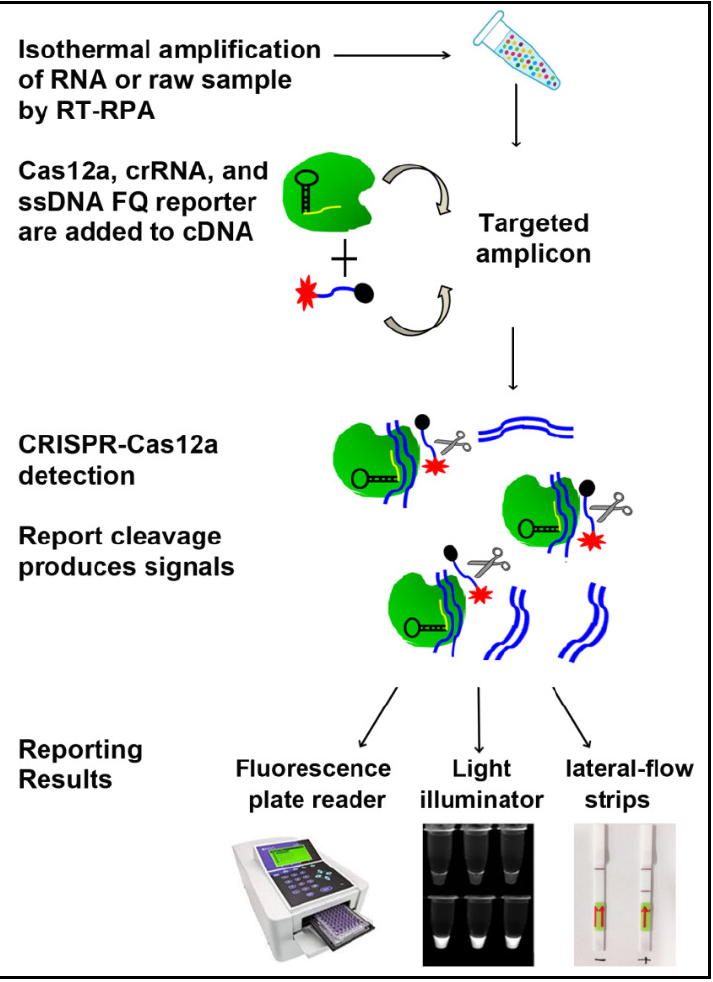
Figure 2. Overview of the clustered regularly interspaced short palindromic repeats (CRISPR)-Cas12a assay to detect SARS-CoV-2. RNA or raw sample was subjected to RT-recombinase polymerase amplification reaction (RT-RPA). The RT-RPA product was mixed with LbaCas12a, CRISPR RNAs (crRNA), and single stranded DNA-FAM-quencher (ssDNA-FQ) reporter. Reaction was performed at 42 °C. Results are read by a fluorescence plate reader, a UV light illuminator, or a paper strip. With the optimized concentrations, fluorescence intensity of CRISPR-Cas12a with the specific crRNAs significantly raised with increase of reaction time in the samples (Figure 3). Furthermore, LbaCas12a with each crRNA could unequivocally identify the corresponding gene of SARS-CoV-2, respectively. Moreover, the crRNA that specifically targeted M gene of SARS-CoV-2 produced more significant fluorescence values in just 5 min, as compared with the crRNAs for N and S genes (Figure 3). Therefore, the crRNA targeting M gene of SARS-CoV-2 might have the highest efficiency for detection of the